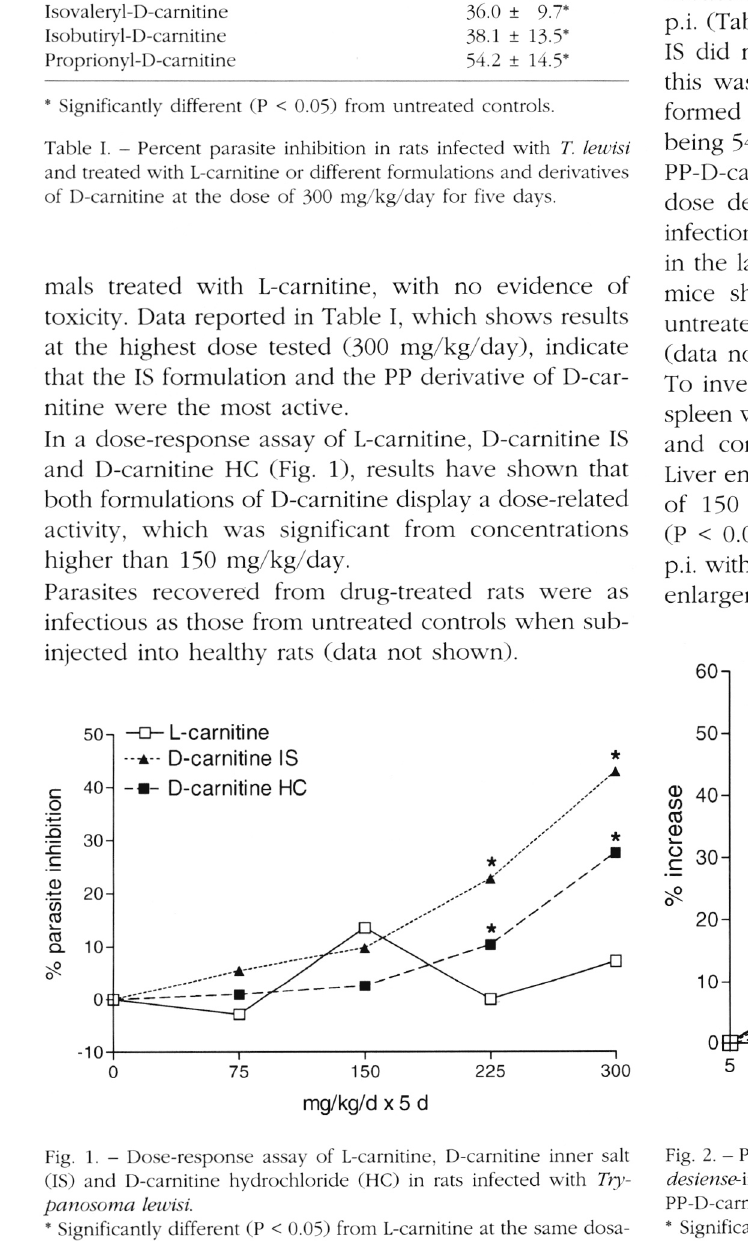
Fig. 2. - Percent increase of liver weight in Trypanosom a brucei rho- desiense -infected mice untreated or treated with different doses of PP-D-carnitine for 15 days. * Significantly different (P < 0.01) from untreated controls.